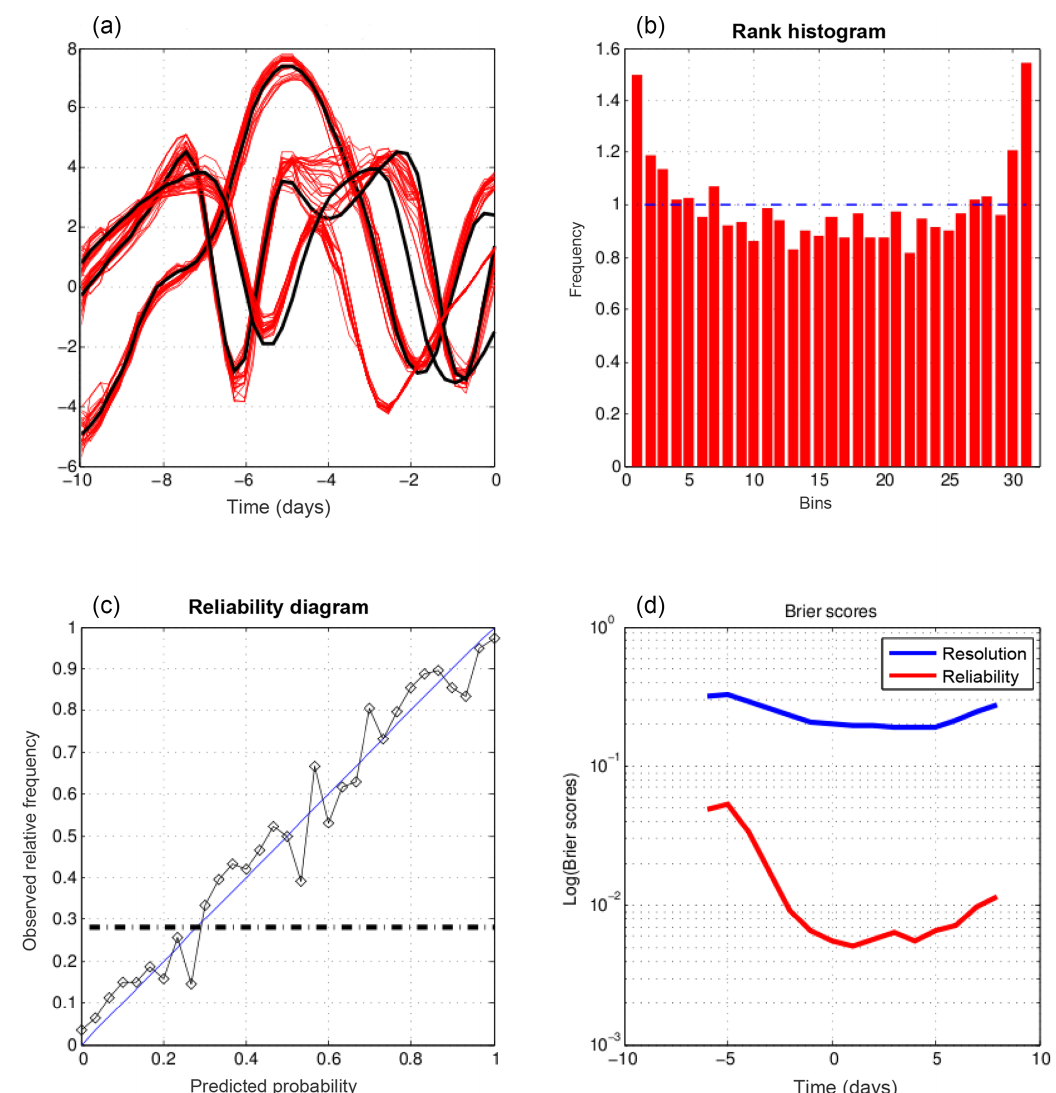
Figure 8. Same as Fig. 7, for assimilations performed with